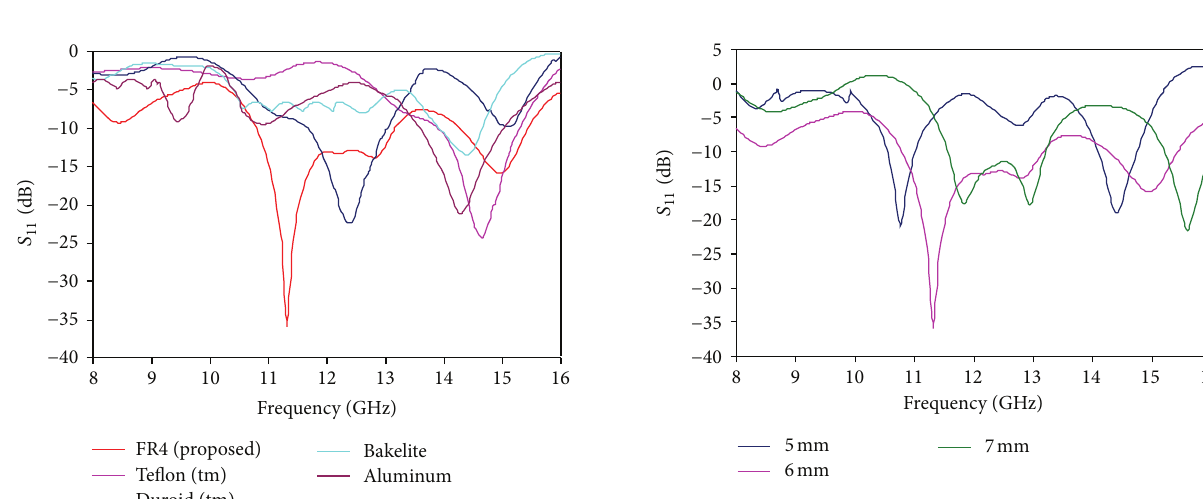
Figure 3: Prototype of the proposed antenna.